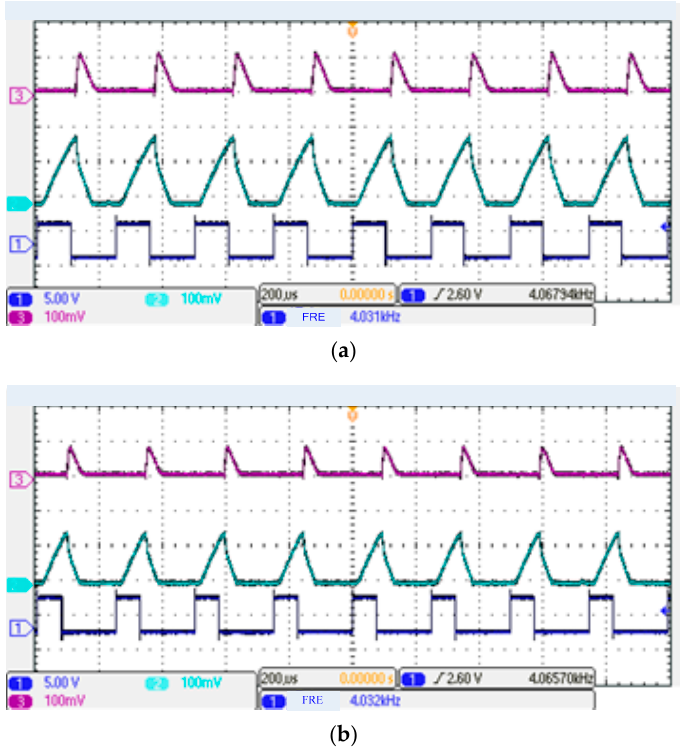
Figure 13. Key waveforms with different duty ratios: ( a ) 45% duty ratio; and ( b ) 30% duty ratio.